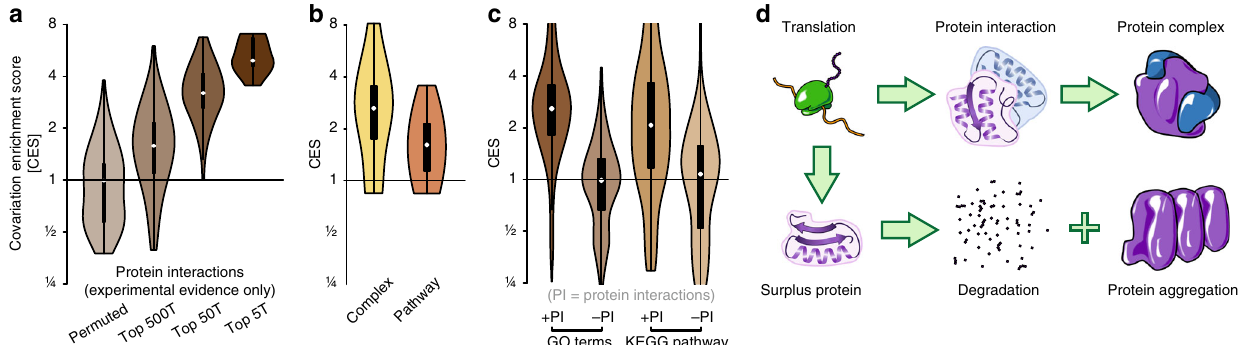
Fig. 4 Proteins that physically interact are speci fi cally enriched for covariations at the RNA level. a Genes that interact on the protein level are highly enriched for covariations. Covariation enrichment of genes that are annotated to be interacting on the protein level according to the STRING database. b Covariations enrichment for genes whose protein products are part of the same physical complex and for genes that are part of the same reaction (pathway). c Gene covariations are mainly driven by protein interaction. Covariation enrichment of genes sharing the same GO annotation or KEGG pathway annotation. GO and KEGG annotations are strati fi ed into pairs with shared annotation and experimentally identi fi ed protein interaction ( + PI) and shared annotation but lack of experimentally identi fi ed protein interaction ( − PI). d Model. Heteromeric protein complexes require proper stoichiometry of protein components. Proteins that are in surplus can be degraded, misfolded or form aggregates.